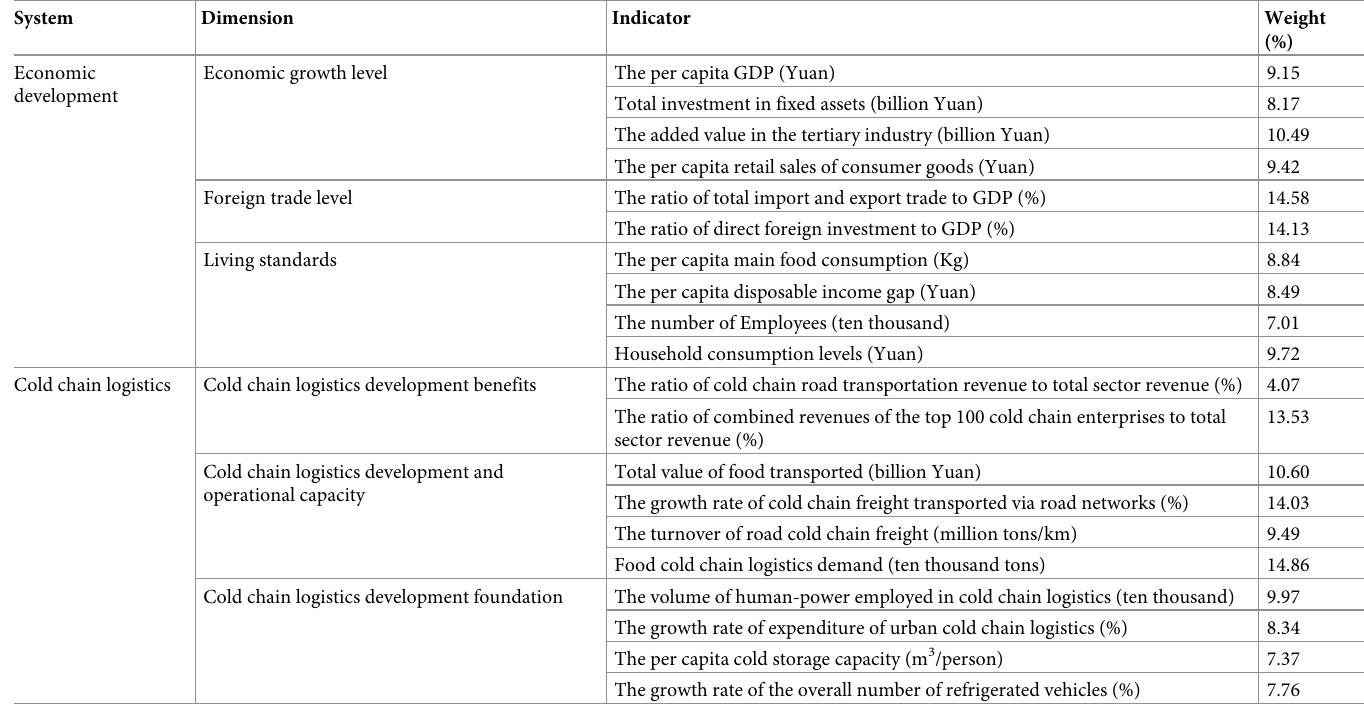
Table 5. Index weight for cold chain logistics and economy.